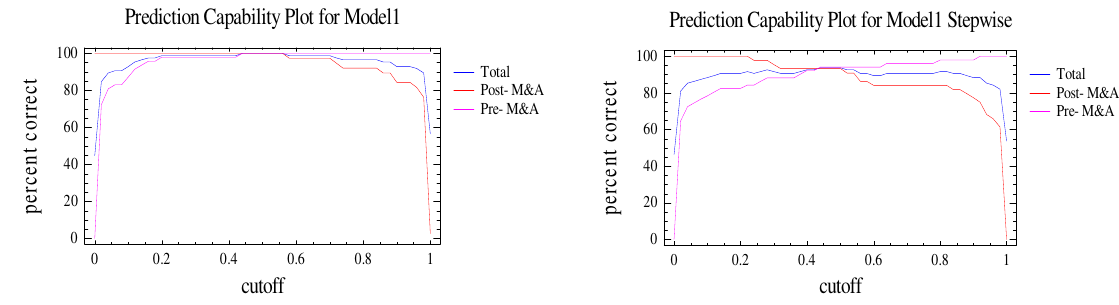
Fig. 1. Prediction capability plot using LR 1 (on the left-hand side) and LR 1 stepwise (on the right-hand side) for pre-post M&A Result for the second model (LR ): The 2